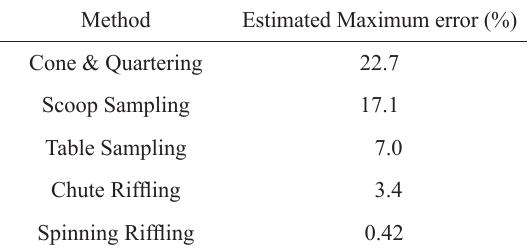
Table 2 Reliability of some sampling/mass reduction